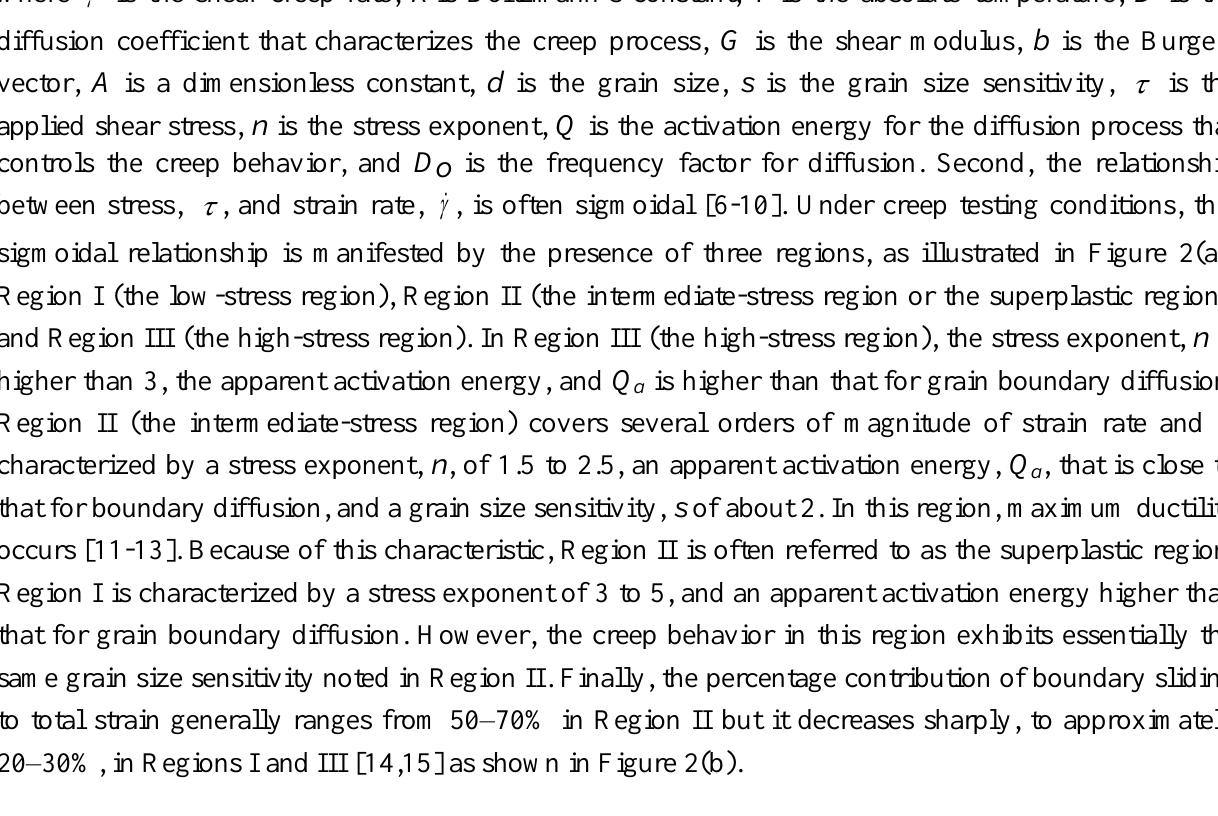
Figure 2. ( a ) Schematic representation regarding the relation between applied stress and strain rate for micrograin superplasticity; ( b ) A schematic representation for the characteristics of micrograin